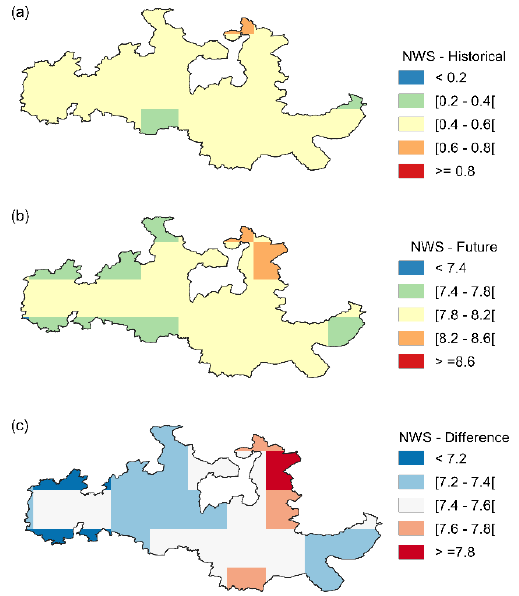
Figure 9. Ensemble-mean of the Number of Warm Spells (NWS) for the Douro Wine Region, bias- corrected by quantile mapping, for the ( a ) historical (1989–2005), ( b ) future (2051–2080) under the RCP8.5, and ( c ) future historical difference.